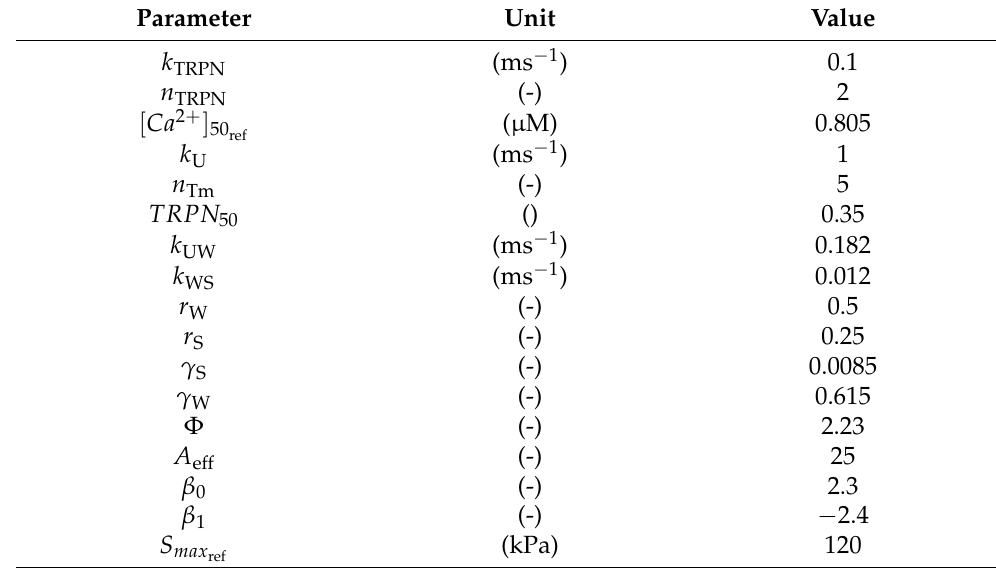
Table A2. Parameters of the Land model [39]